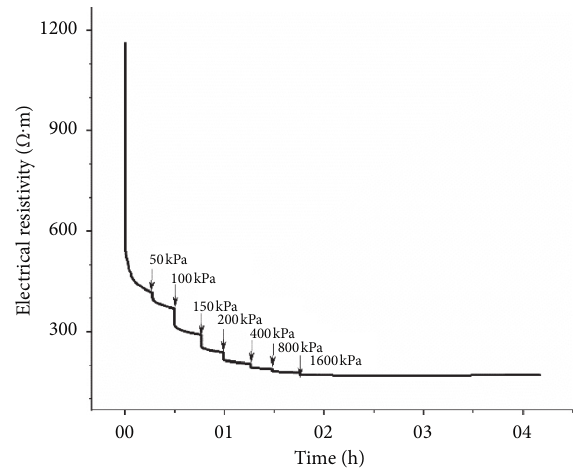
Figure 4: Time-electric resistivity curve in the consolidation test.